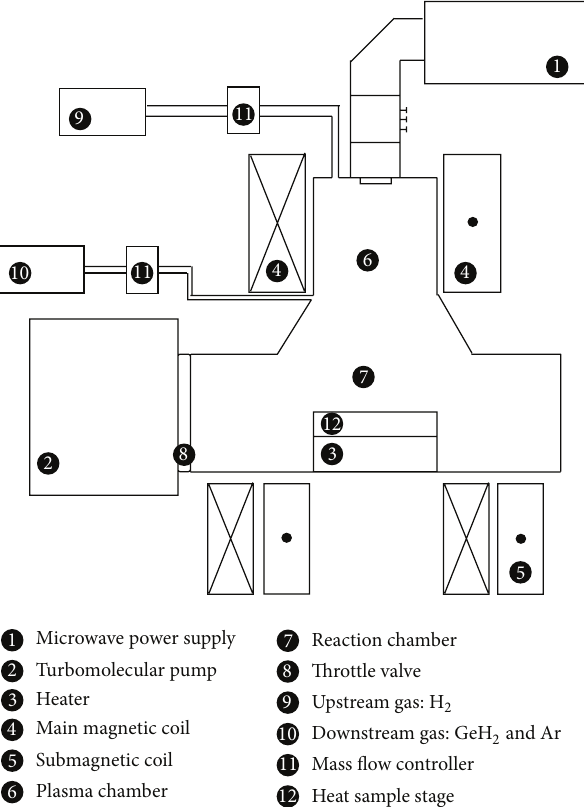
Figure 1: A schematic diagram of the ECRCVD system illustrates the experimental